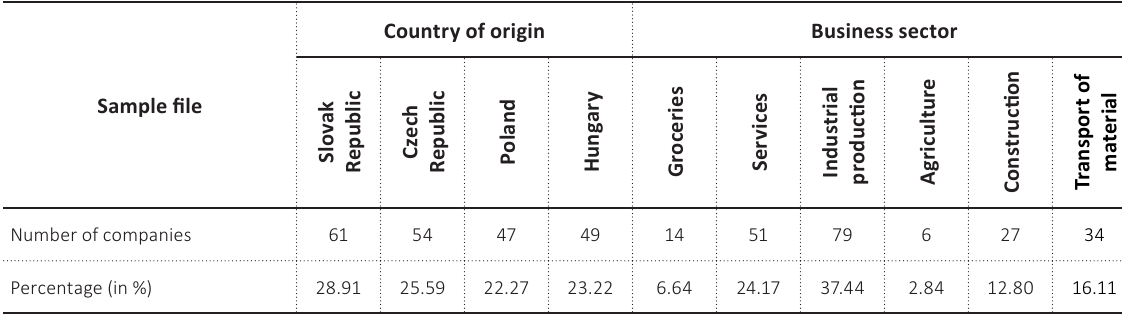
Table 1. Structure of a sample